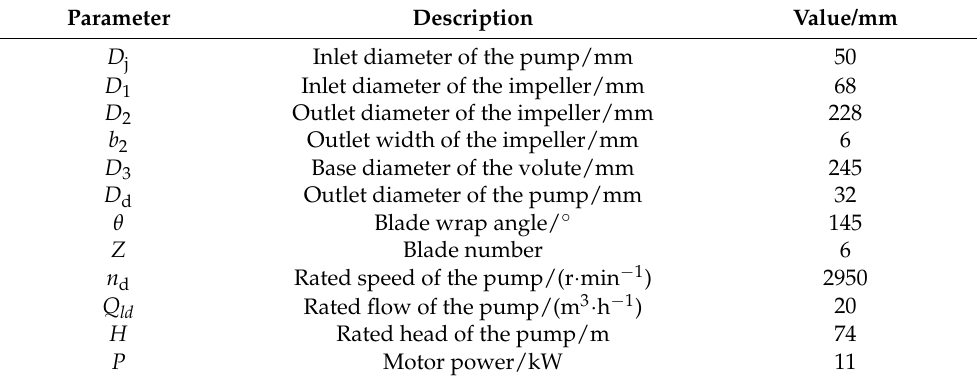
Table 1. Main parameters of the model pump.